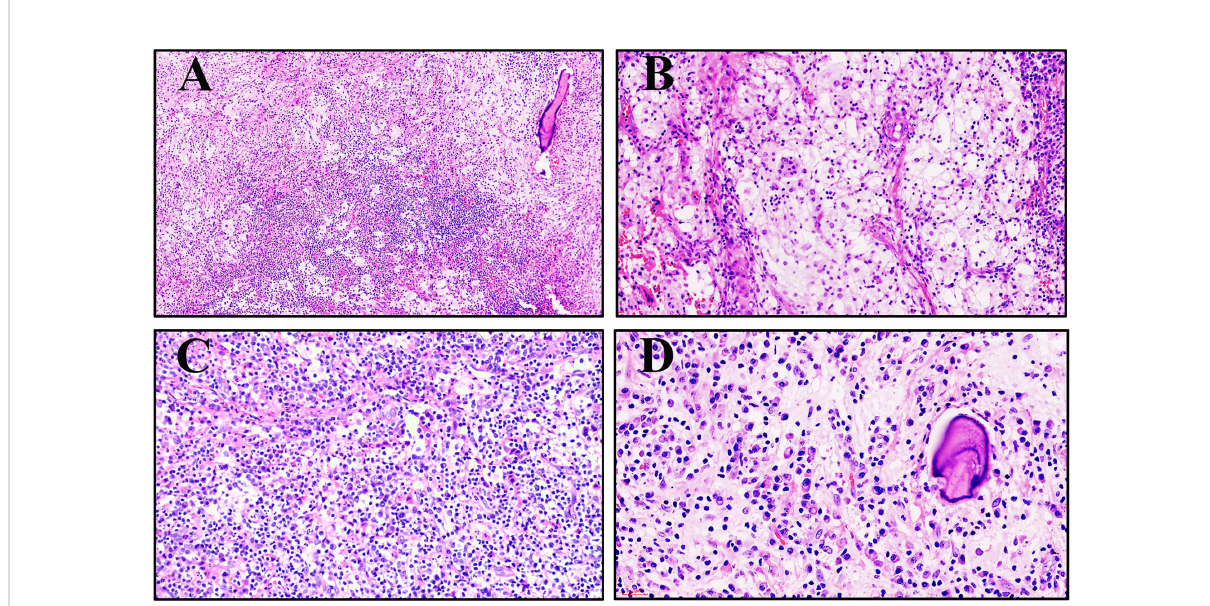
FIGURE 2 Morphology of primary intraosseous Rosai – Dorfman disease (RDD). (A) An in fi ltrative pattern of RDD in the medullary cavity (patient #3, hematoxylin and eosin ×100). (B) Large histiocytes with abundant clear to eosinophilic cytoplasm tended to form loose clusters surrounded by a mixed in fl ammatory in fi ltrate (patient #2, hematoxylin and eosin ×200). (C) Large histiocytes demonstrated emperipolesis of the neutrophils, lymphocytes, and plasma cells (patient #4, hematoxylin and eosin ×200). (D) The tumor cells are enmeshed in a fi brotic stroma that contains a